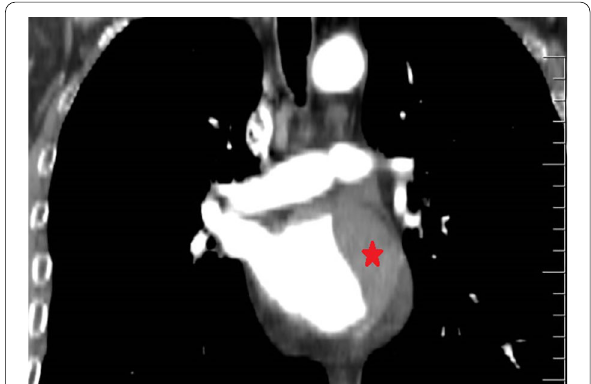
Fig. 3 Coronal computed tomography (CT) imaging demonstrating a non-enhancing left atrial intramural mass consistent with hematoma